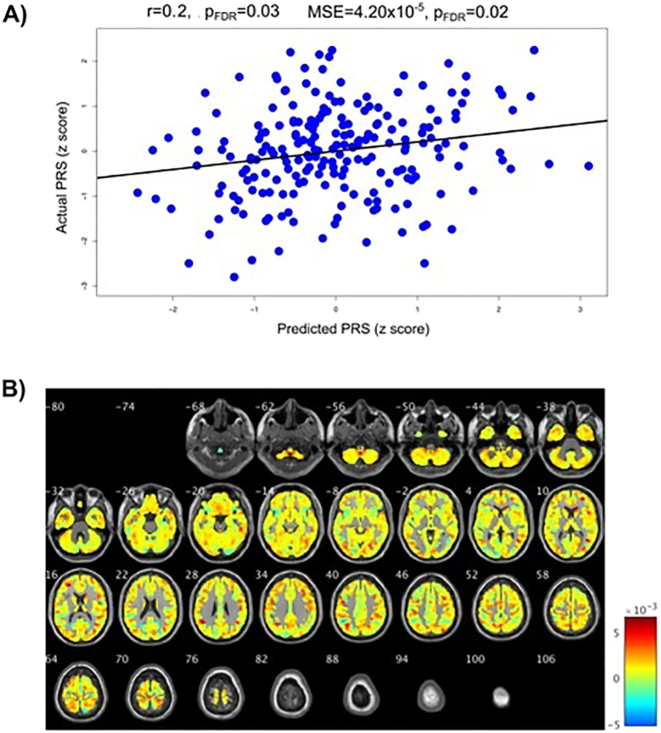
Results for the autism polygenic risk score (PRS). A) Correlations between actual autism PRS and the PRS predicted from the grey matter volume maps. pFDR = False Discover Rate corrected p-values. B) Weight maps of contribution of voxels across the whole brain for the predicted autism PRS shown in A (in the whole sample, N = 213).